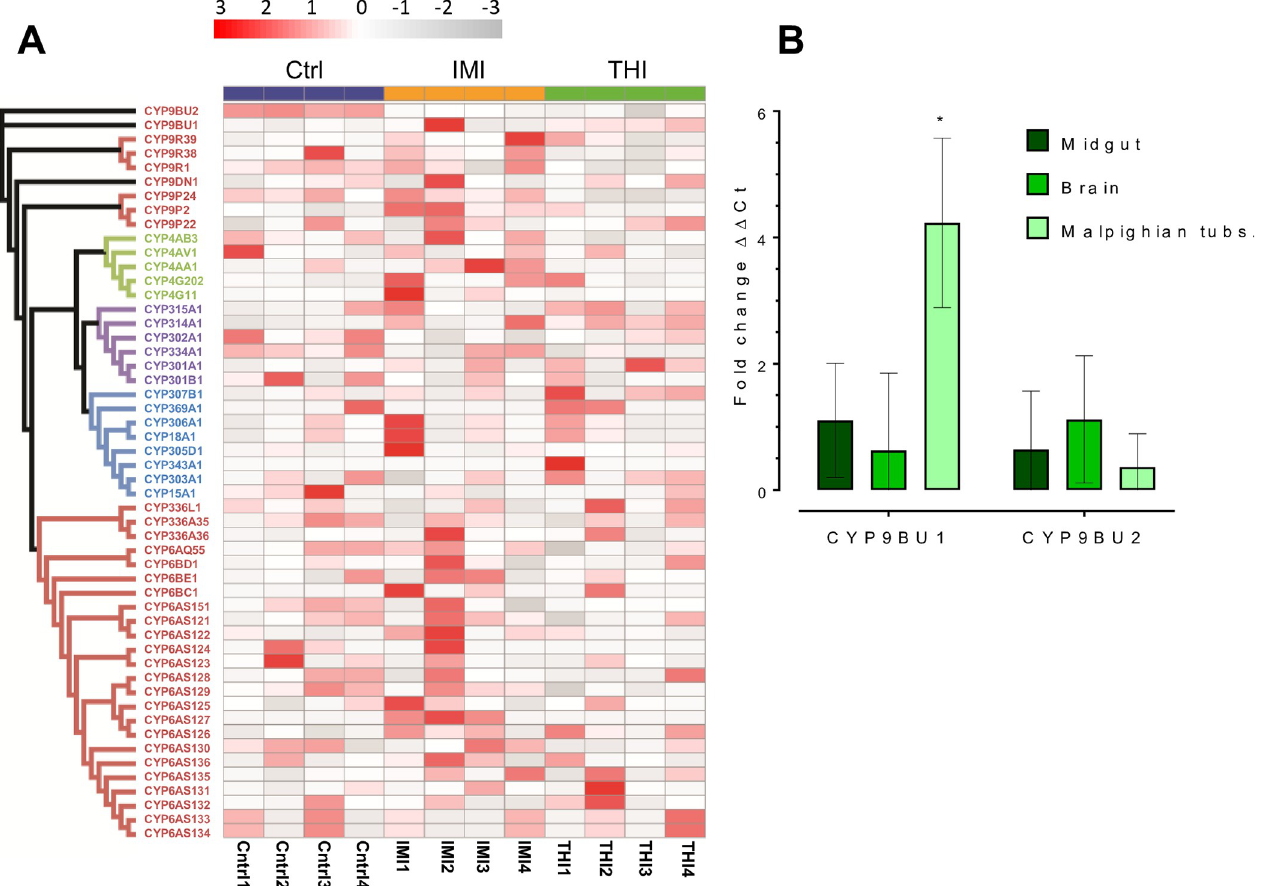
Fig 4. Expression of O . bicornis P450s after exposure to neonicotinoids and in different tissues. (A) Expression heat map of O . bicornis P450s after exposure of female bees to imidacloprid (IMI), thiacloprid (THI) or insecticide dilutent (Ctrl). Expression in each of the four replicates per treatment is derived from scaled FPKM values for each P450 transcript. A maximum likelihood tree of Osmia bicornis P450s is shown to the left of the heatmap. (B) Relative expression (fold change) of O . bicornis thiacloprid metabolising CYP9 genes in different tissues of female bees measured by quantitative PCR. Significant differences (p < 0.01) in expression between tissues is denoted using an asterisk above bars as determined by one-way ANOVA with post hoc Tukey HSD.